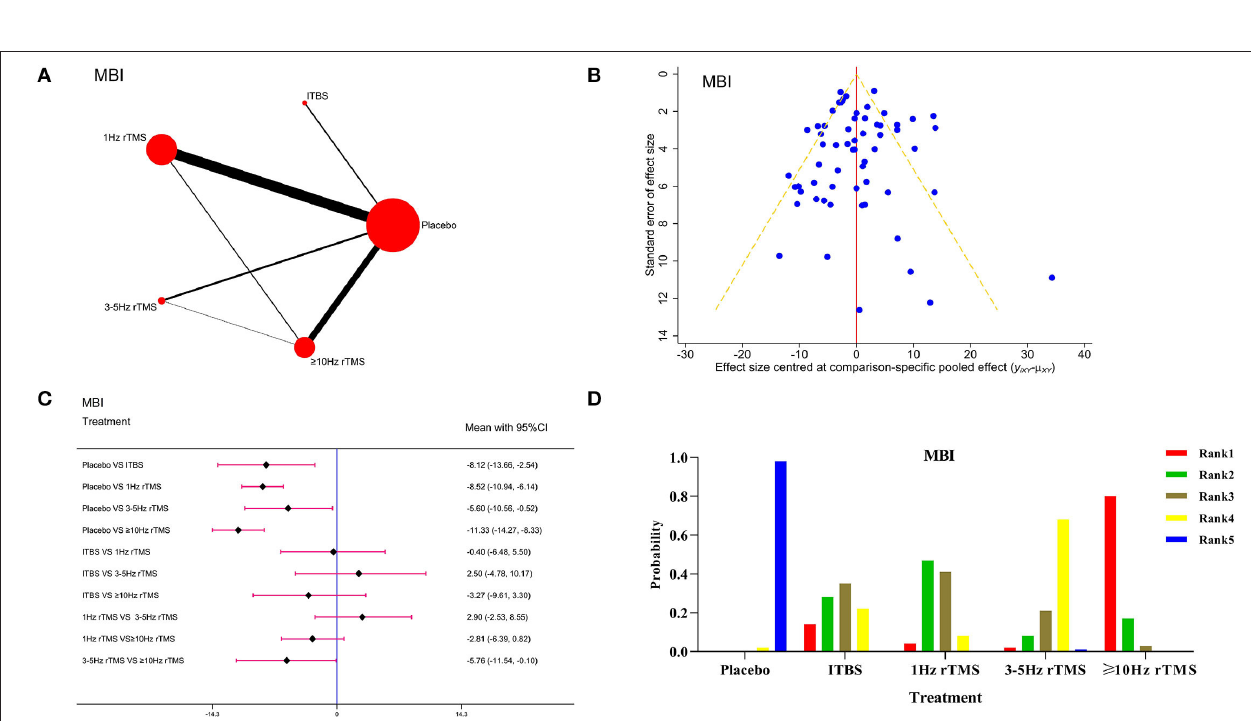
FIGURE 4 | Network meta-analysis results for Modified Barthel Index (MBI). (A) : Network plot; (B) : Funnel plot; (C) : Forest plot; (D) : The figure of ranking probability.